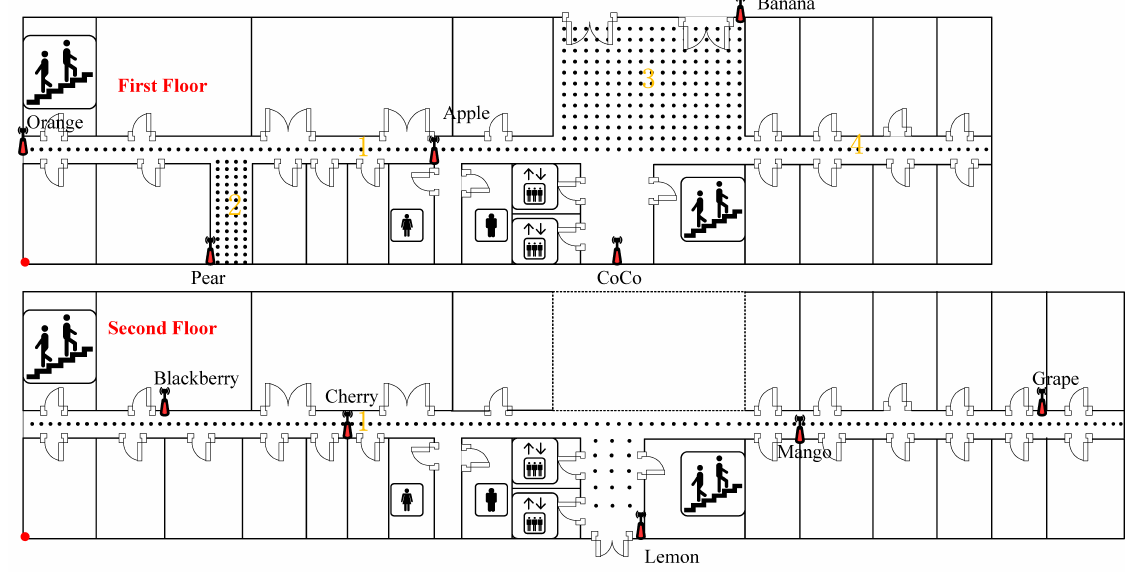
Figure 9. Layout of the first and the second